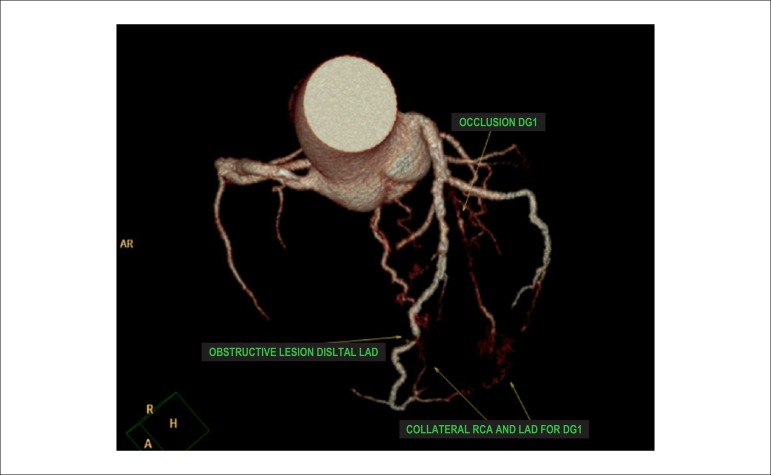
Case 8 - Angio-CT showing significant obstructive alterations and evidence of advanced coronary artery disease. DG1: diagonal 1 coronary artery branch; LAD: left anterior descending artery; RCA: right coronary artery.